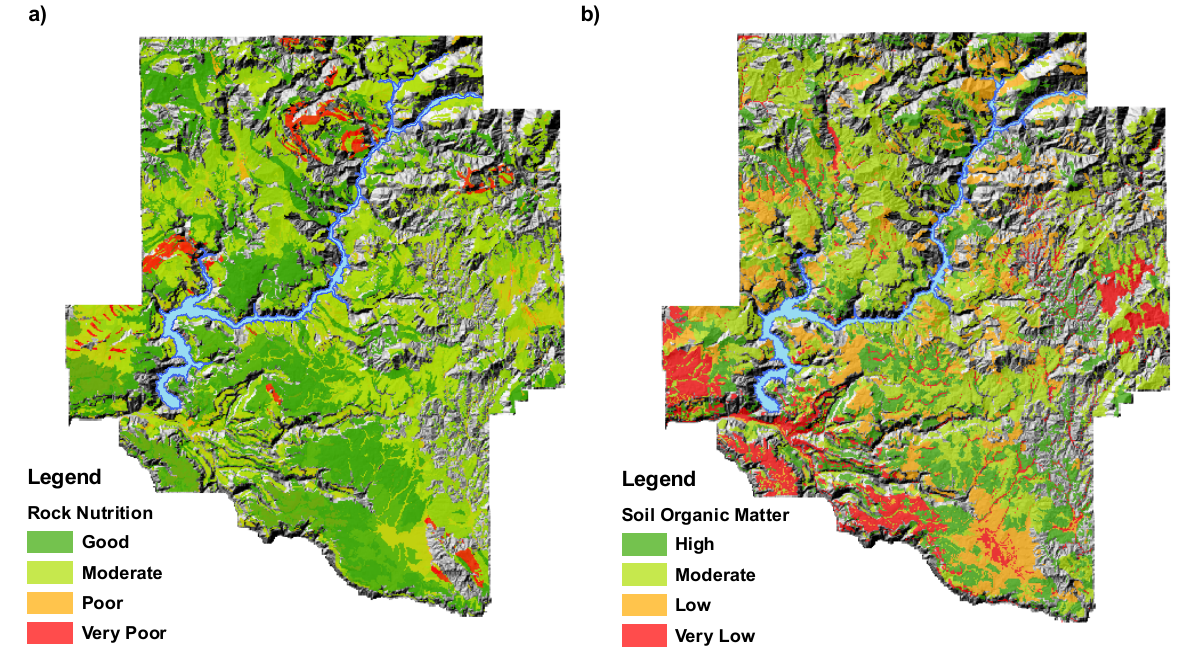
Table 1. Rock nutrient status as a function of weathering potential and forest soil